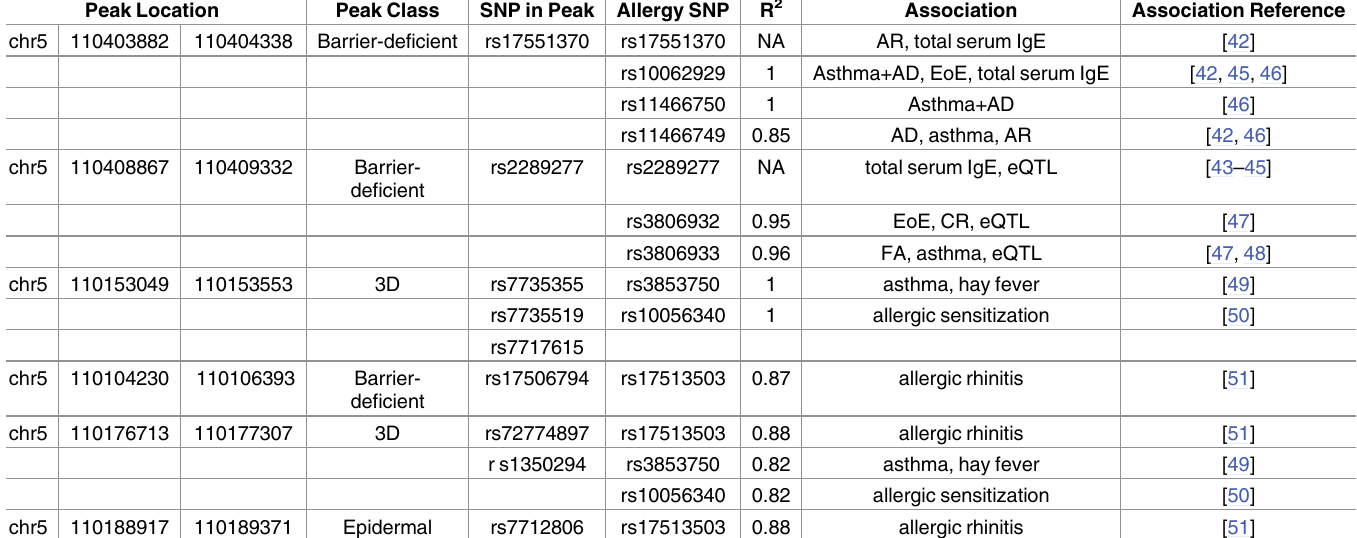
Table 1. Allergy-associated SNPS in LD with dynamic peaks in the TSLP TAD. Locationsof dynamicpeaks containing SNPs that are in LD with allergic diseaseassociatedSNPs. R 2 indicatesLD based on 1000 genomesphase1 CEU data. Abbreviations: AR- allergicrhinitis; AD- atopic dermatitis; EoE- eosin- ophilicesophagitis; CR- chronicrhinitis; eQTL- expressionquantitative trait locus. Peak